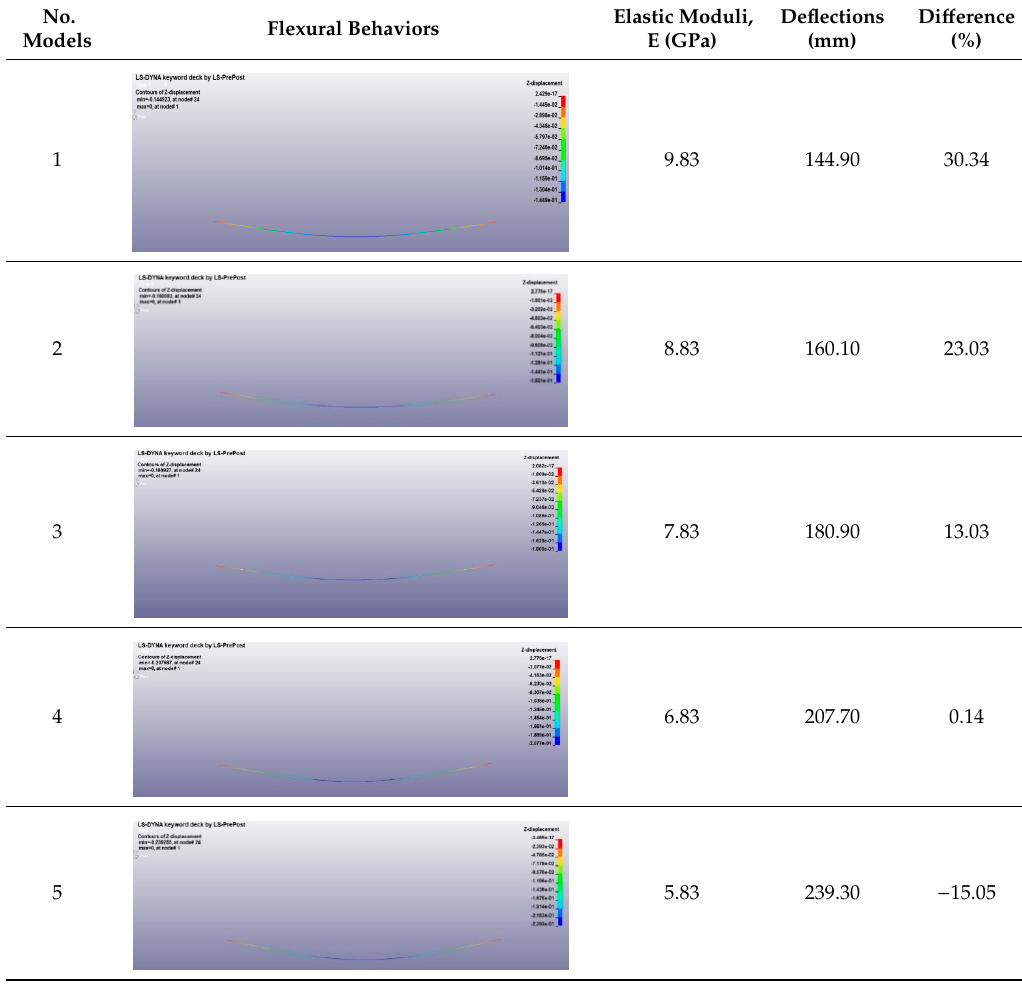
Table 3. Finite element analysis for determining the optimized simulation model for a FFU composite beam under bending load.